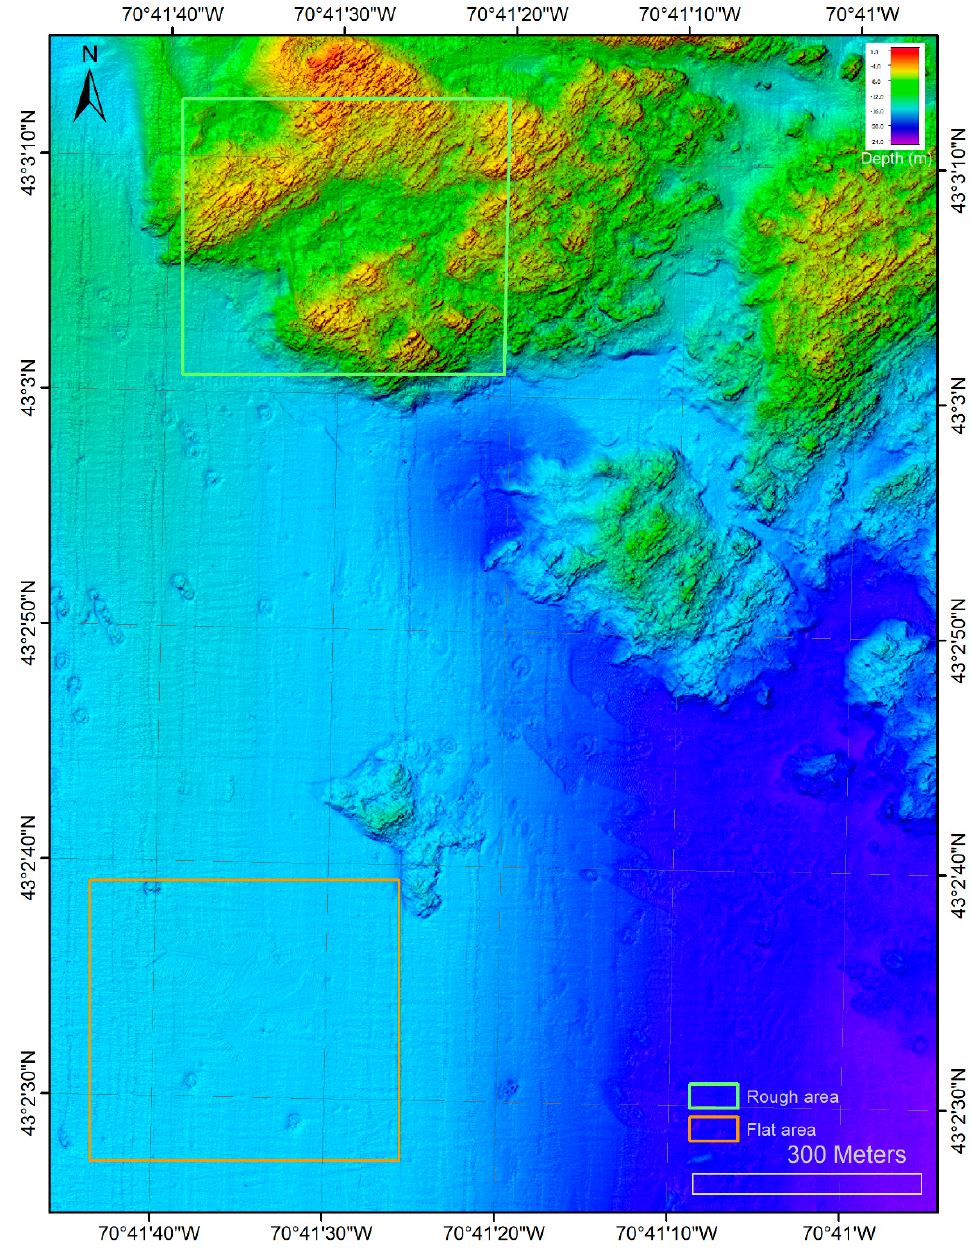
Figure 4. Overview showing the location of the survey using 1 m grid cell sizes. The two boxes delineate the flat area and the rough area that are featured in the discussions.